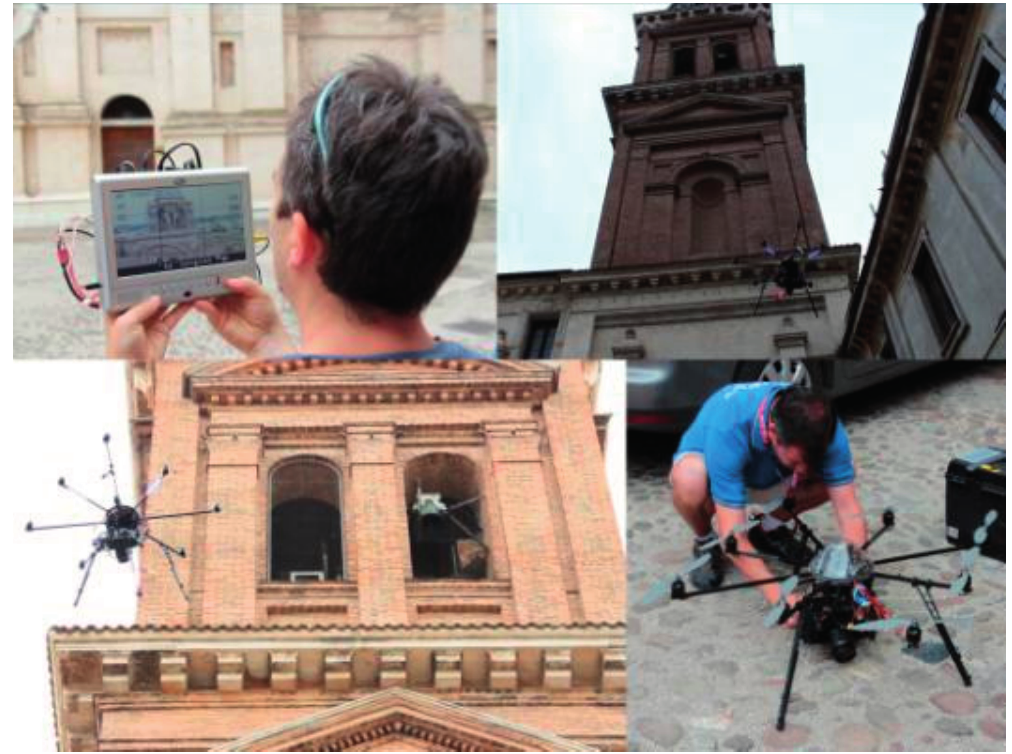
Figure 6. The octocopter employed for the bell tower acquisition, and the Wi-Fi camera